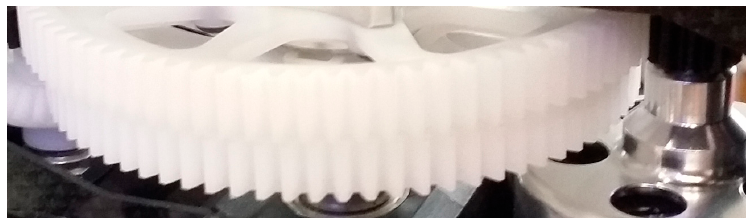
Figure 2. Gear set configuration for the helicopter Align T-Rex 700.